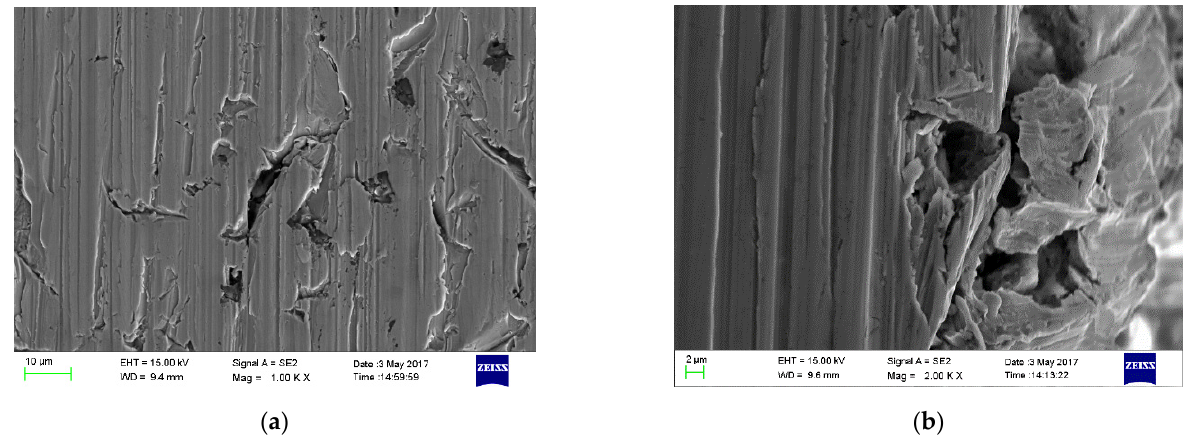
Figure 10. SEM Microstructure of KMN blade fatigue specimen. ( a ) The middle of the cross section; ( b ) the cross section close to the surface.